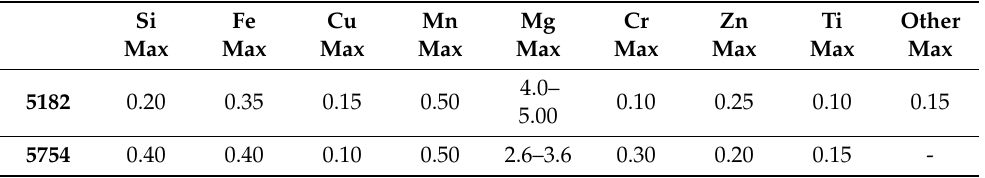
Table 2. Aluminum alloys chemical compositions (% at.).